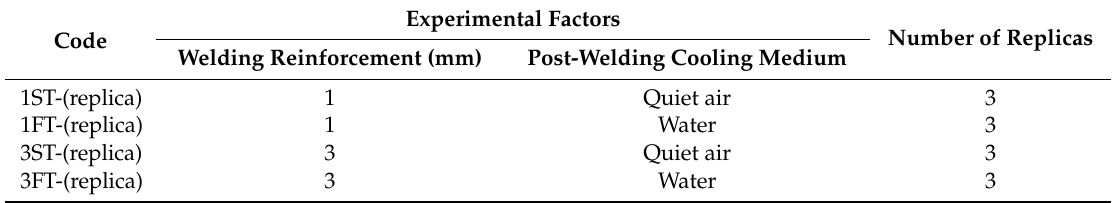
Table 3. Coding used for the uniaxial tension test specimens.